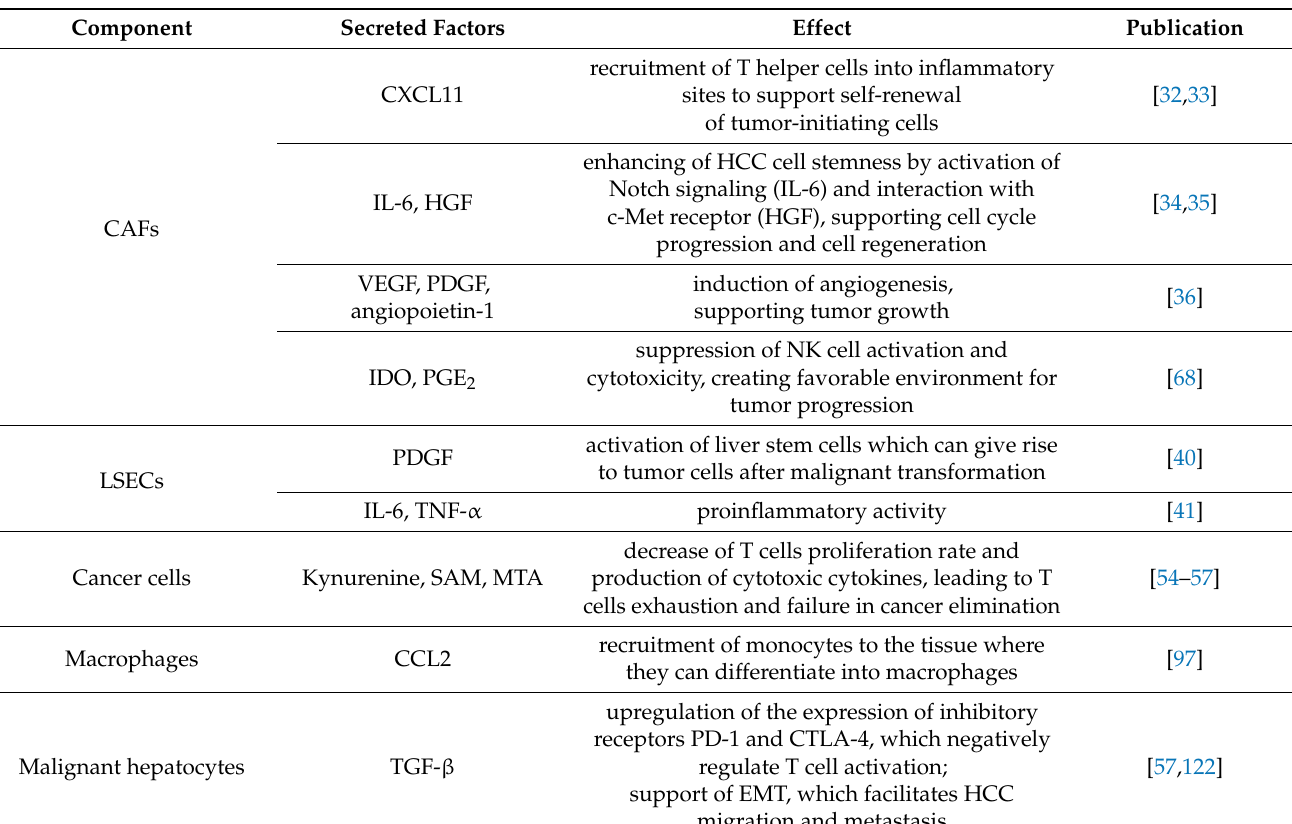
Table 1. TME components and their major effects on HCC